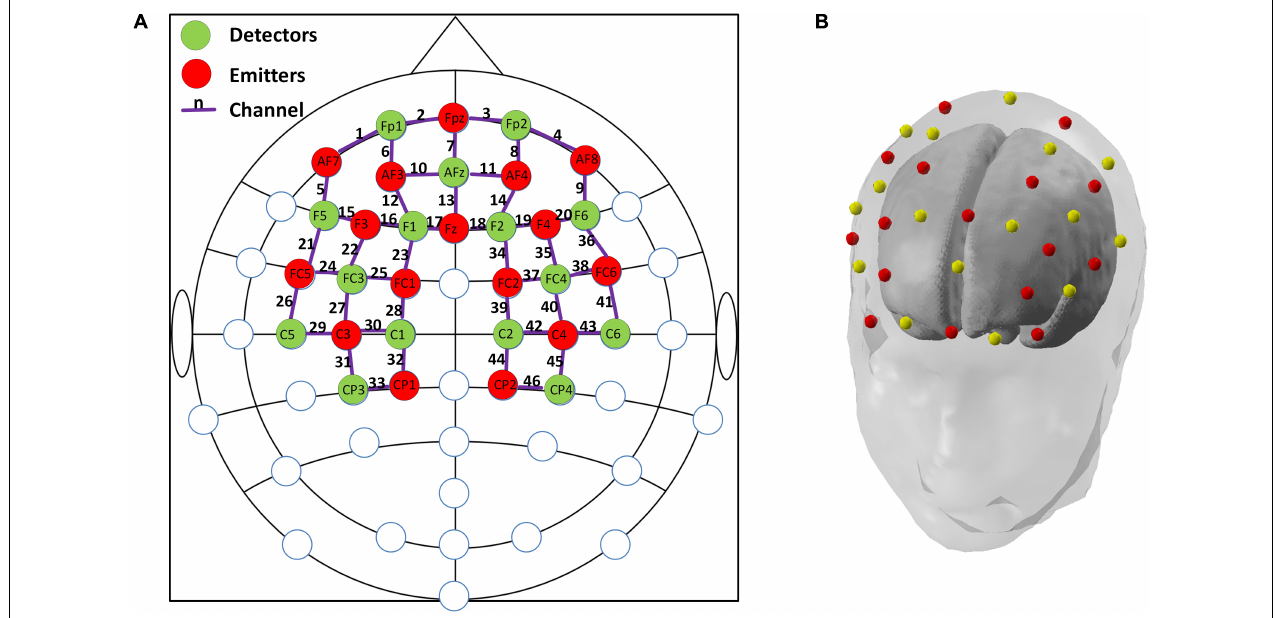
FIGURE 2 | (A) The configuration of fNIRS optodes and channels. Red circles denote the emitters, green circles denote the detectors, the purple lines and numbers are defined as fNIRS channels. Labels within circles denote the locations in international 10–20 EEG placement. Frontal area: channels 1–20; Left parietal: channels 21–33; and Right parietal: channels 34–46; (B) . A demonstration of the standard 3-D head model with the emitters (red dots) and detectors (yellow dots) generated by nirsLAB (NIRx Medizintechnik GmbH, Germany).